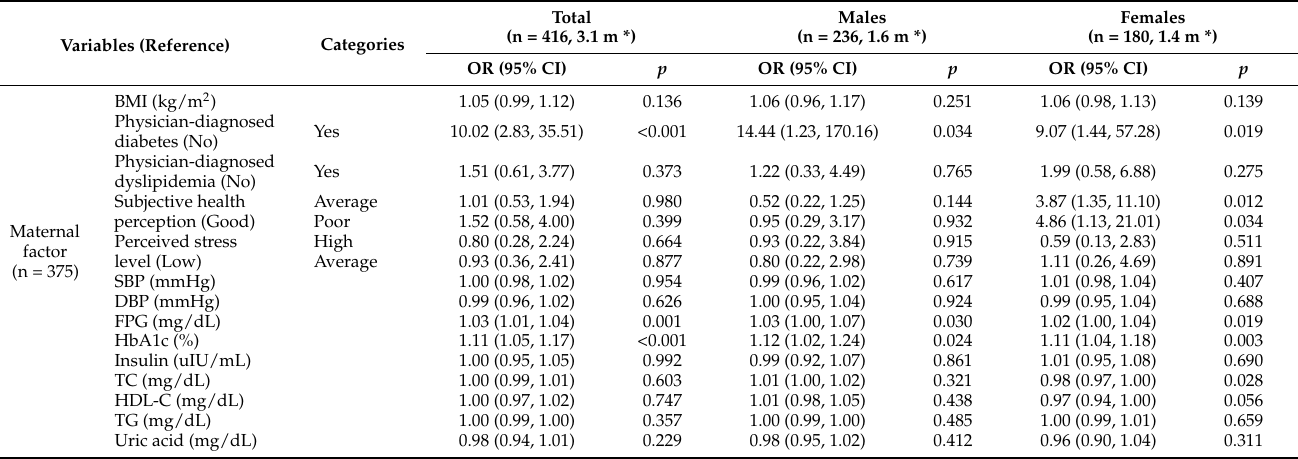
Table 5. Maternal Factors Affecting the High-Risk Group for Adolescent